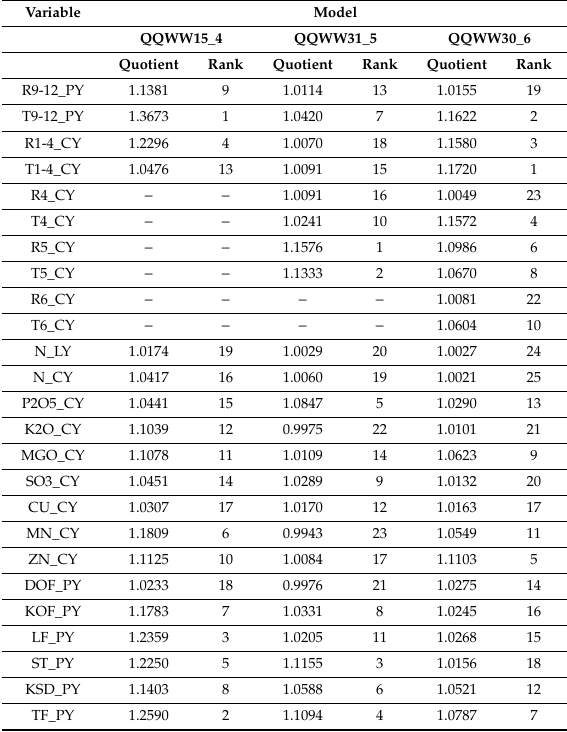
Table 5. Sensitivity analysis of neural networks.